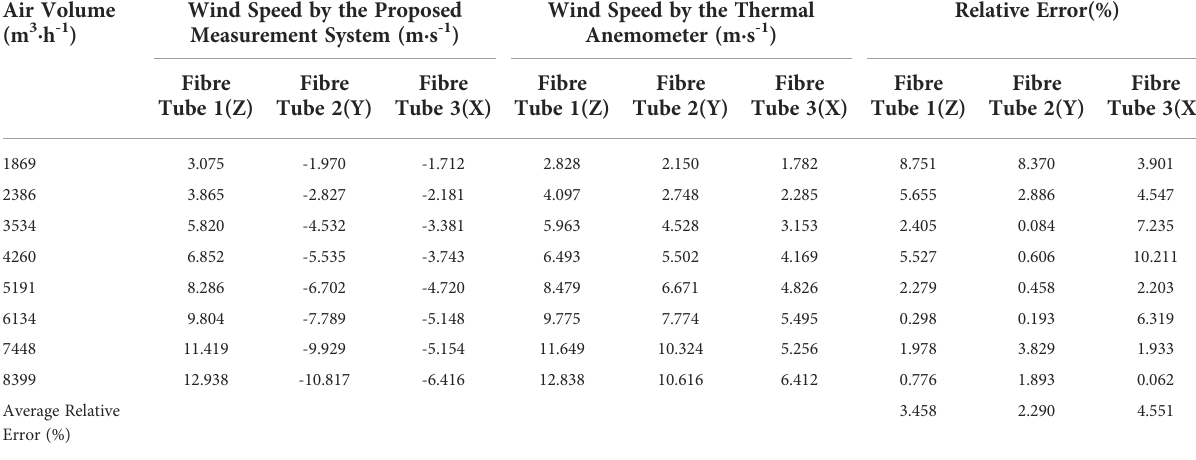
TABLE 3 The wind speed by the thermal anemometer and the calibrated measurement system. Air Volume (m 3 ·h -1 )